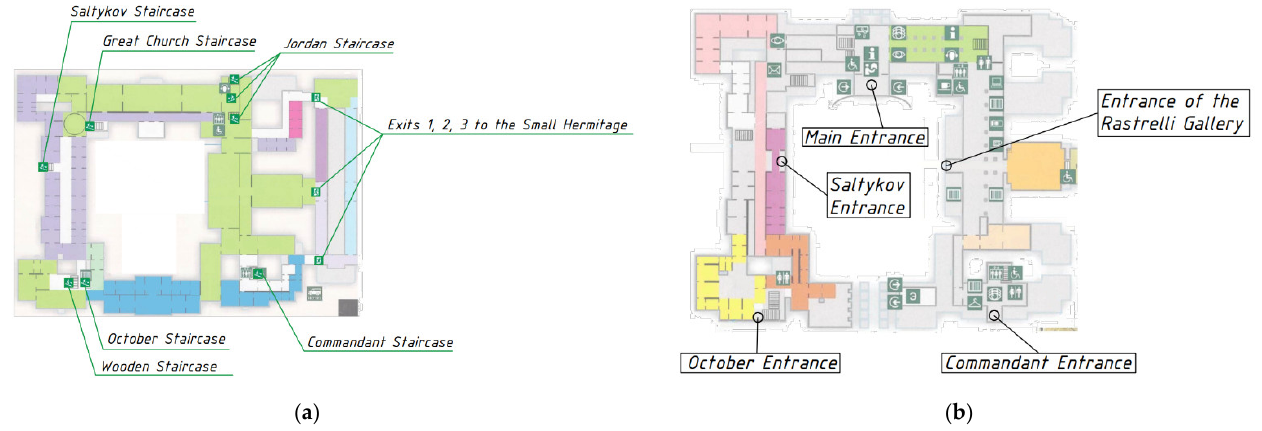
Figure 4. Distribution of staircases throughout the building ( a ); evacuation exits on the first floor plan ( b ).